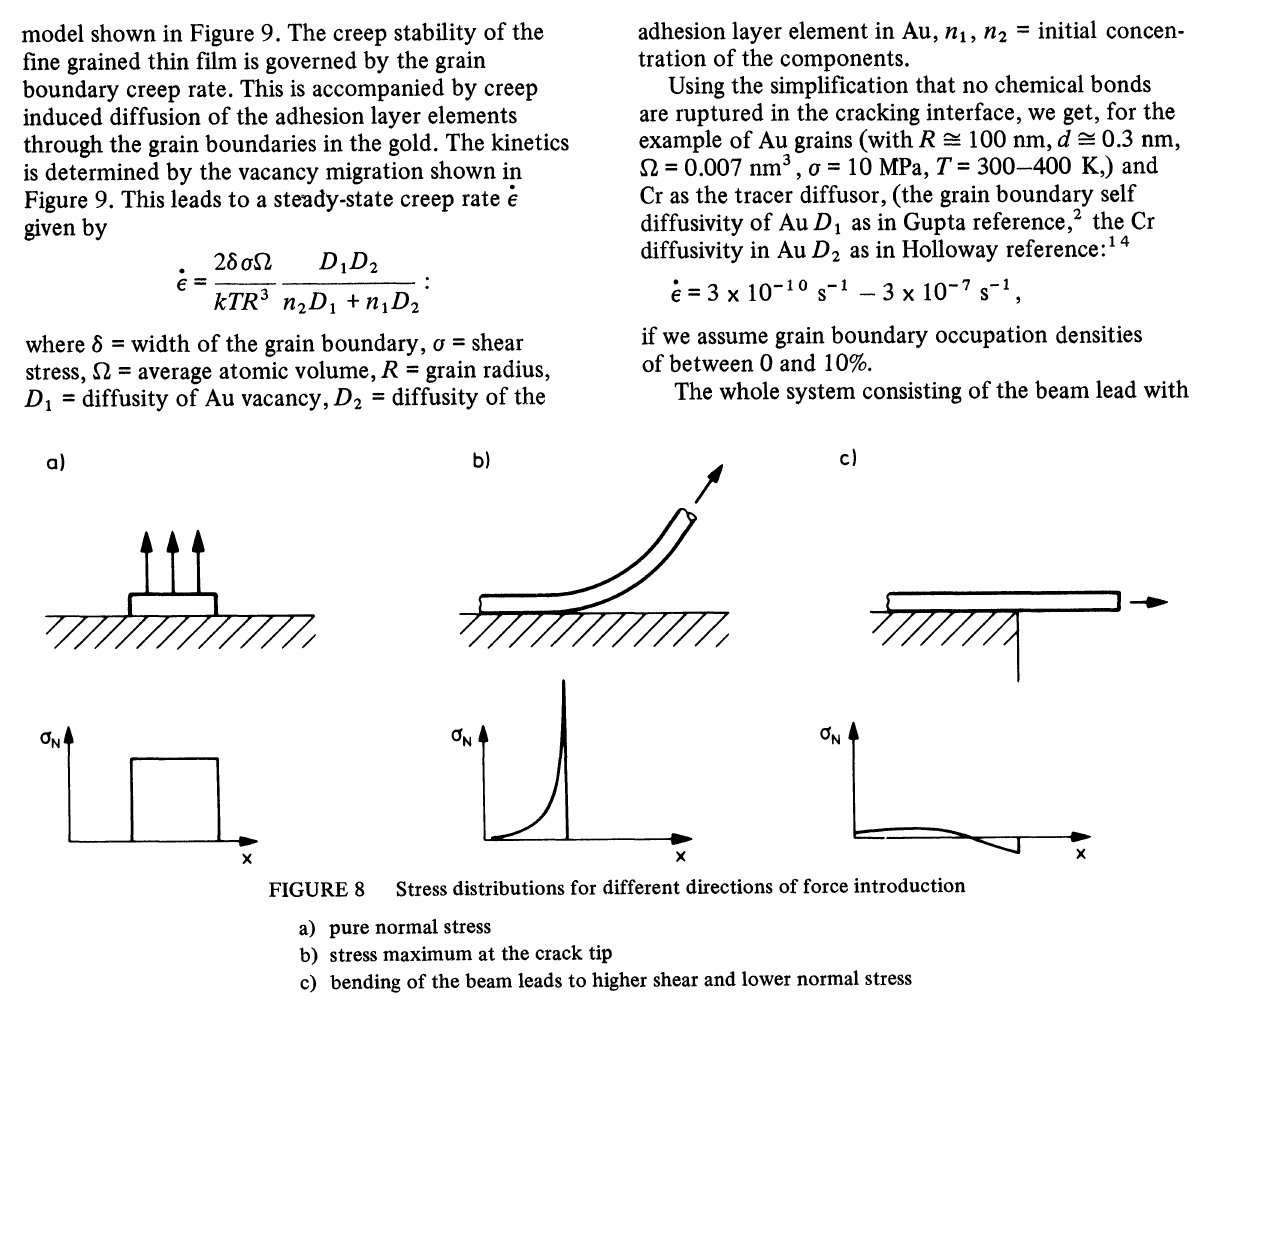
Stress distributions for different directions of force